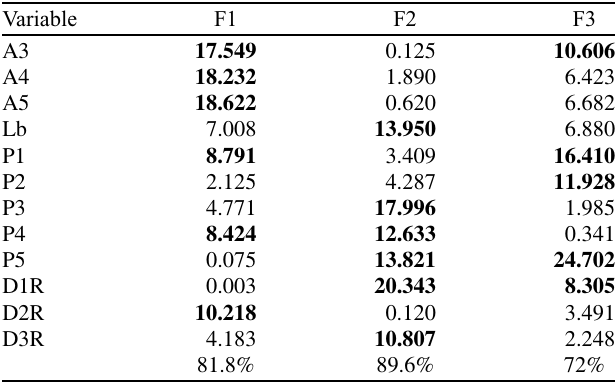
Table 6. Parameter contribution (%) to the total variability (highest contributions displayed in bold).